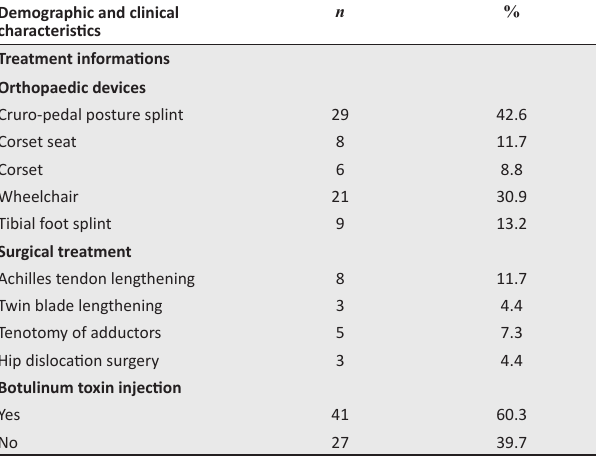
TABLE 1 (Continues...): Biographical information of children with cerebral palsy and their families ( N = 68). Demographic and clinical